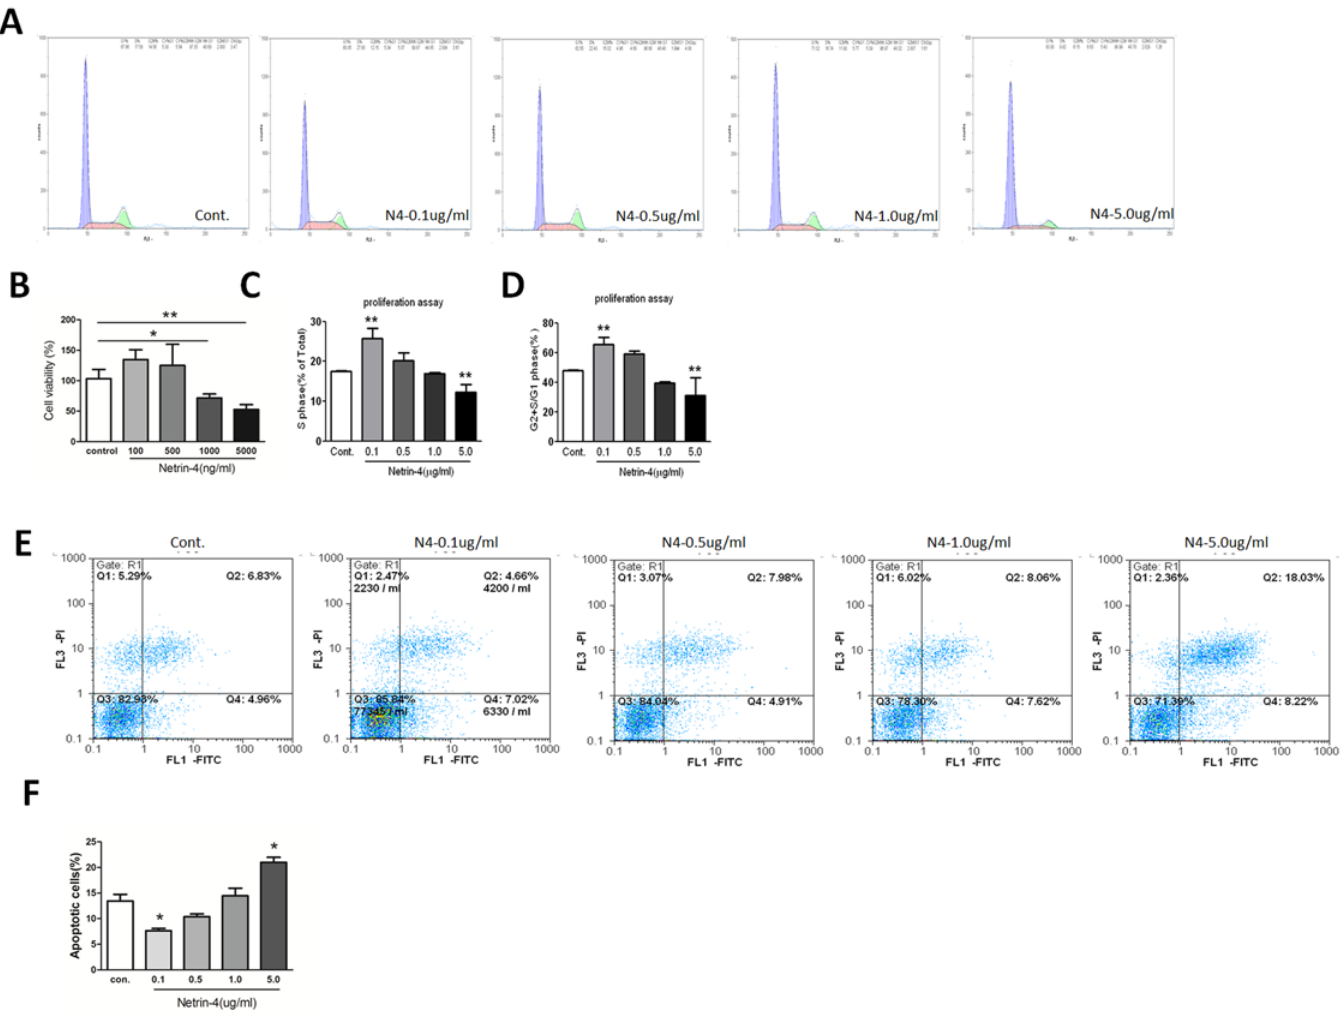
Fig 2. Cell viability, HUVEC proliferation and apoptosis on different doses of netrin-4 was detected by using the CCK-8 assay and flow cytometry. (A) Cultured HUVECs were serum-starved for 24 h followed by 72 h culture in serum free media with or without dosage netrin-4 protein. The cells were then harvested, stained with propidium iodide (PI), and analyzed by flow cytometry. The cell proliferation rate was expressed as the percentage of cells in the S phase and as the G2 + S/G1 ratio ( ** p < 0.01). (B) Cell viability detected by CCK-8. (C) S phase percentage of cells. (D) G2 + S/G1 ratio. (E) Apoptosis assay by flow cytometry, analysis with annexin V-FITC / PI double staining. The numbers in the upper left, upper right, lower left and lower right quadrants represent the percentage of necrotic cells (annexin V positive, PI positive), advanced apoptotic cells (annexin V negative, PI positive), viable cells (annexin V negative, PI negative) and early apoptotic cells (annexin V positive, PI negative), respectively. The values represent the mean percentages of apoptotic cells in different groups ( * p < 0.05). (F) Quantitative results of the apoptotic cells. Each value represents the mean ± SD, n = 3. * p < 0.05; ** p < 0.01; compared with the control